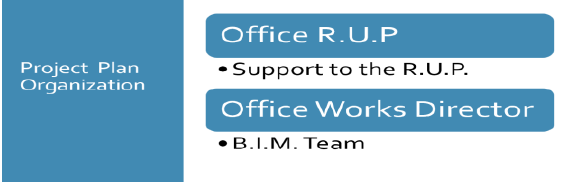
Figure 4 . BIM Team position in the Plan Organization